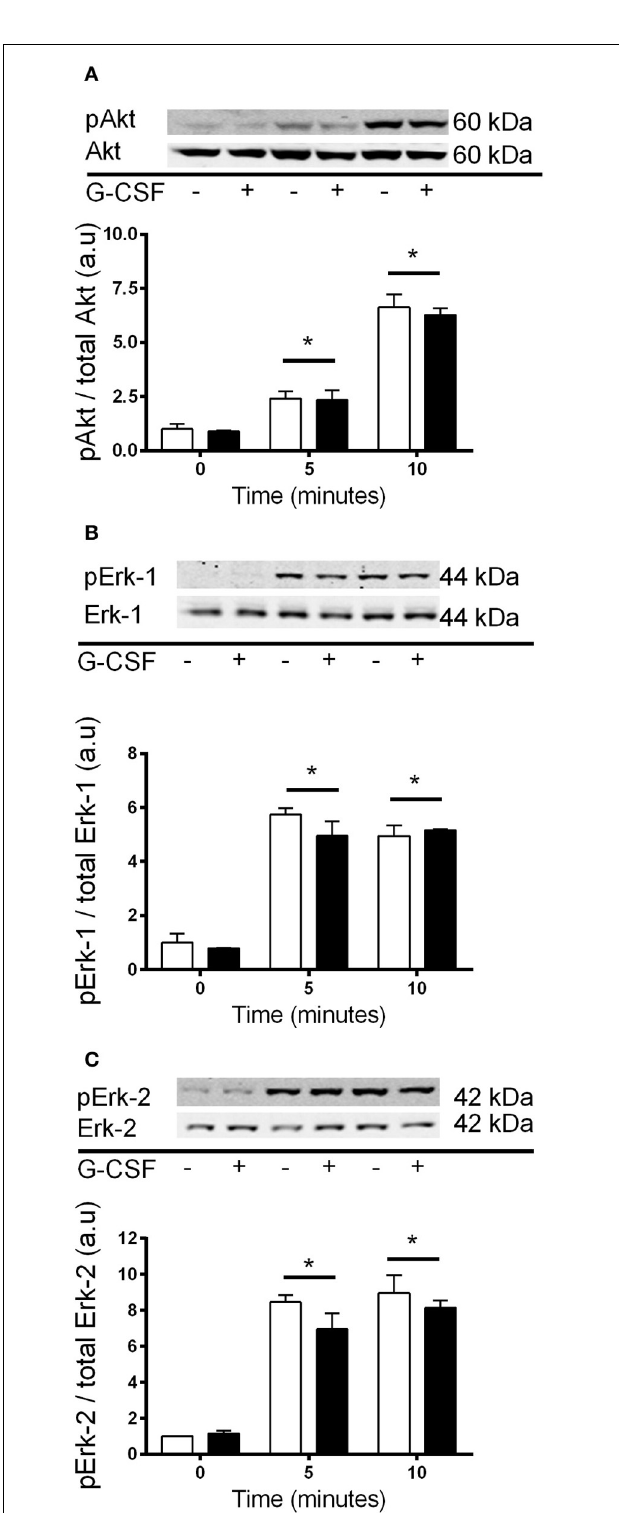
on skeletal muscle via its receptor. We also show that G-CSF